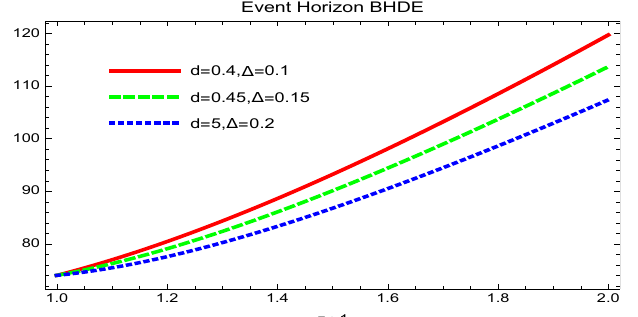
Figure 2. Plot of Hubble parameter H versus redshift parameter 1 + z for BHDE model with event horizon for GDP braneworld cosmology.